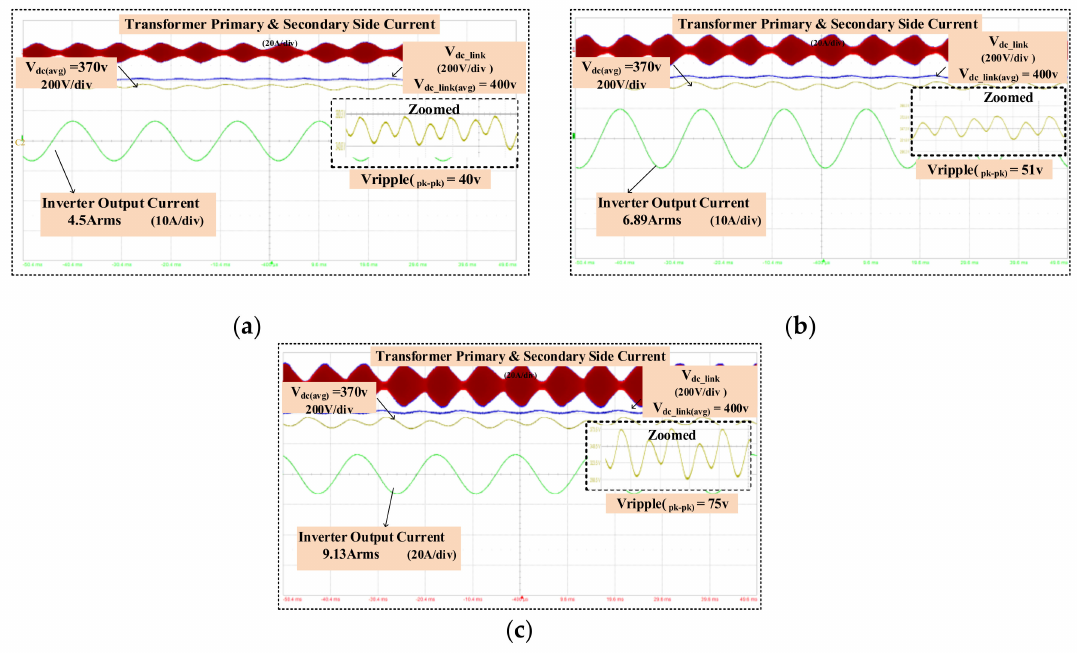
Figure 12. Experimental waveforms without the proposed double line frequency ripple elimination method (from top to bottom: transformer primary & secondary current, dc-link voltage, DC input voltage and inverter output current): ( a ) 1 kW; ( b ) 1.5 kW; ( c ) 2.0